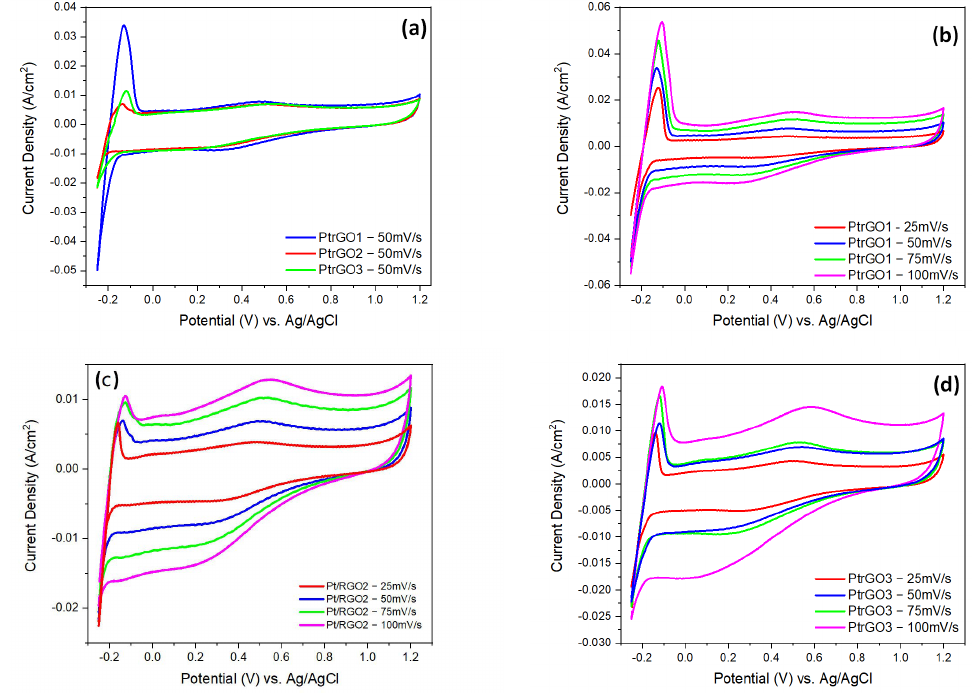
Figure 9. ( a ) The overlayed CVs of PtrGO1, PtrGO2 and PtrGO3 recorded with 50 mV/s in domain of − 0.25 to 1.2 V vs. Ag/AgCl; ( b – d ) CV of PtrGO1, PtrGO2, PtrGO3 recorded at 25 mV/s, 50 mV/s, 75mV/s and 100 mV/s scan